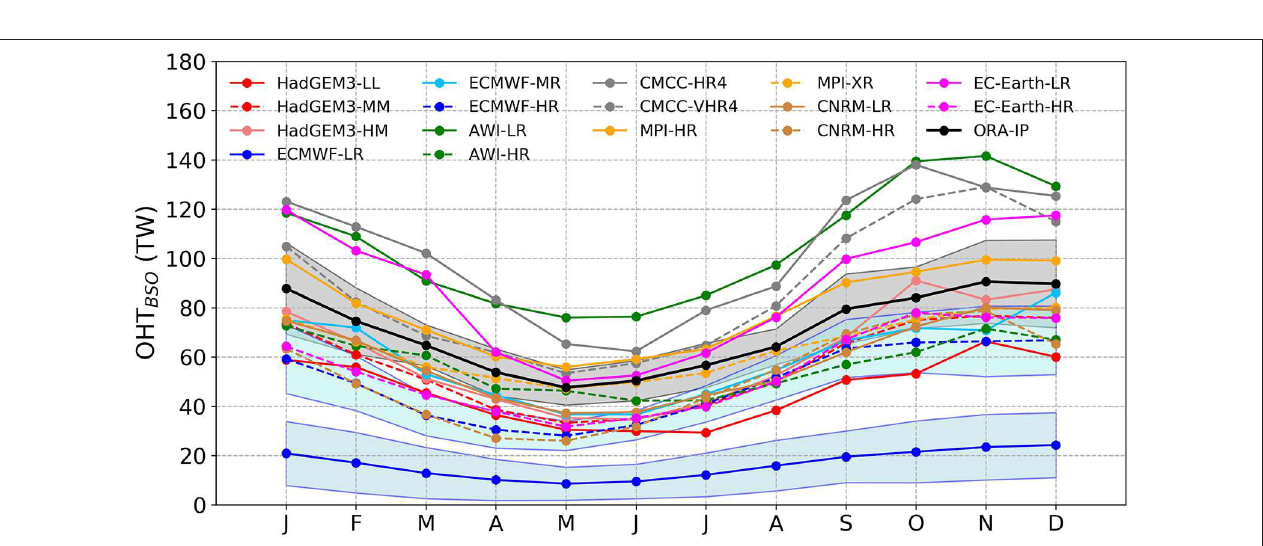
FIGURE 6 | Seasonal cycle of ocean heat transport (OHT) at the Barents Sea Opening (BSO, large transect, 20 ◦ E, 70–74.5 ◦ N) averaged over 1993–2010 using HighResMIP hist-1950 model outputs and ORA-IP reanalyses. The blue shadings of ECMWF-LR and ECMWF-HR represent the ensemble standard deviation (six members for each). The gray shading of reanalyses represents the temporal standard